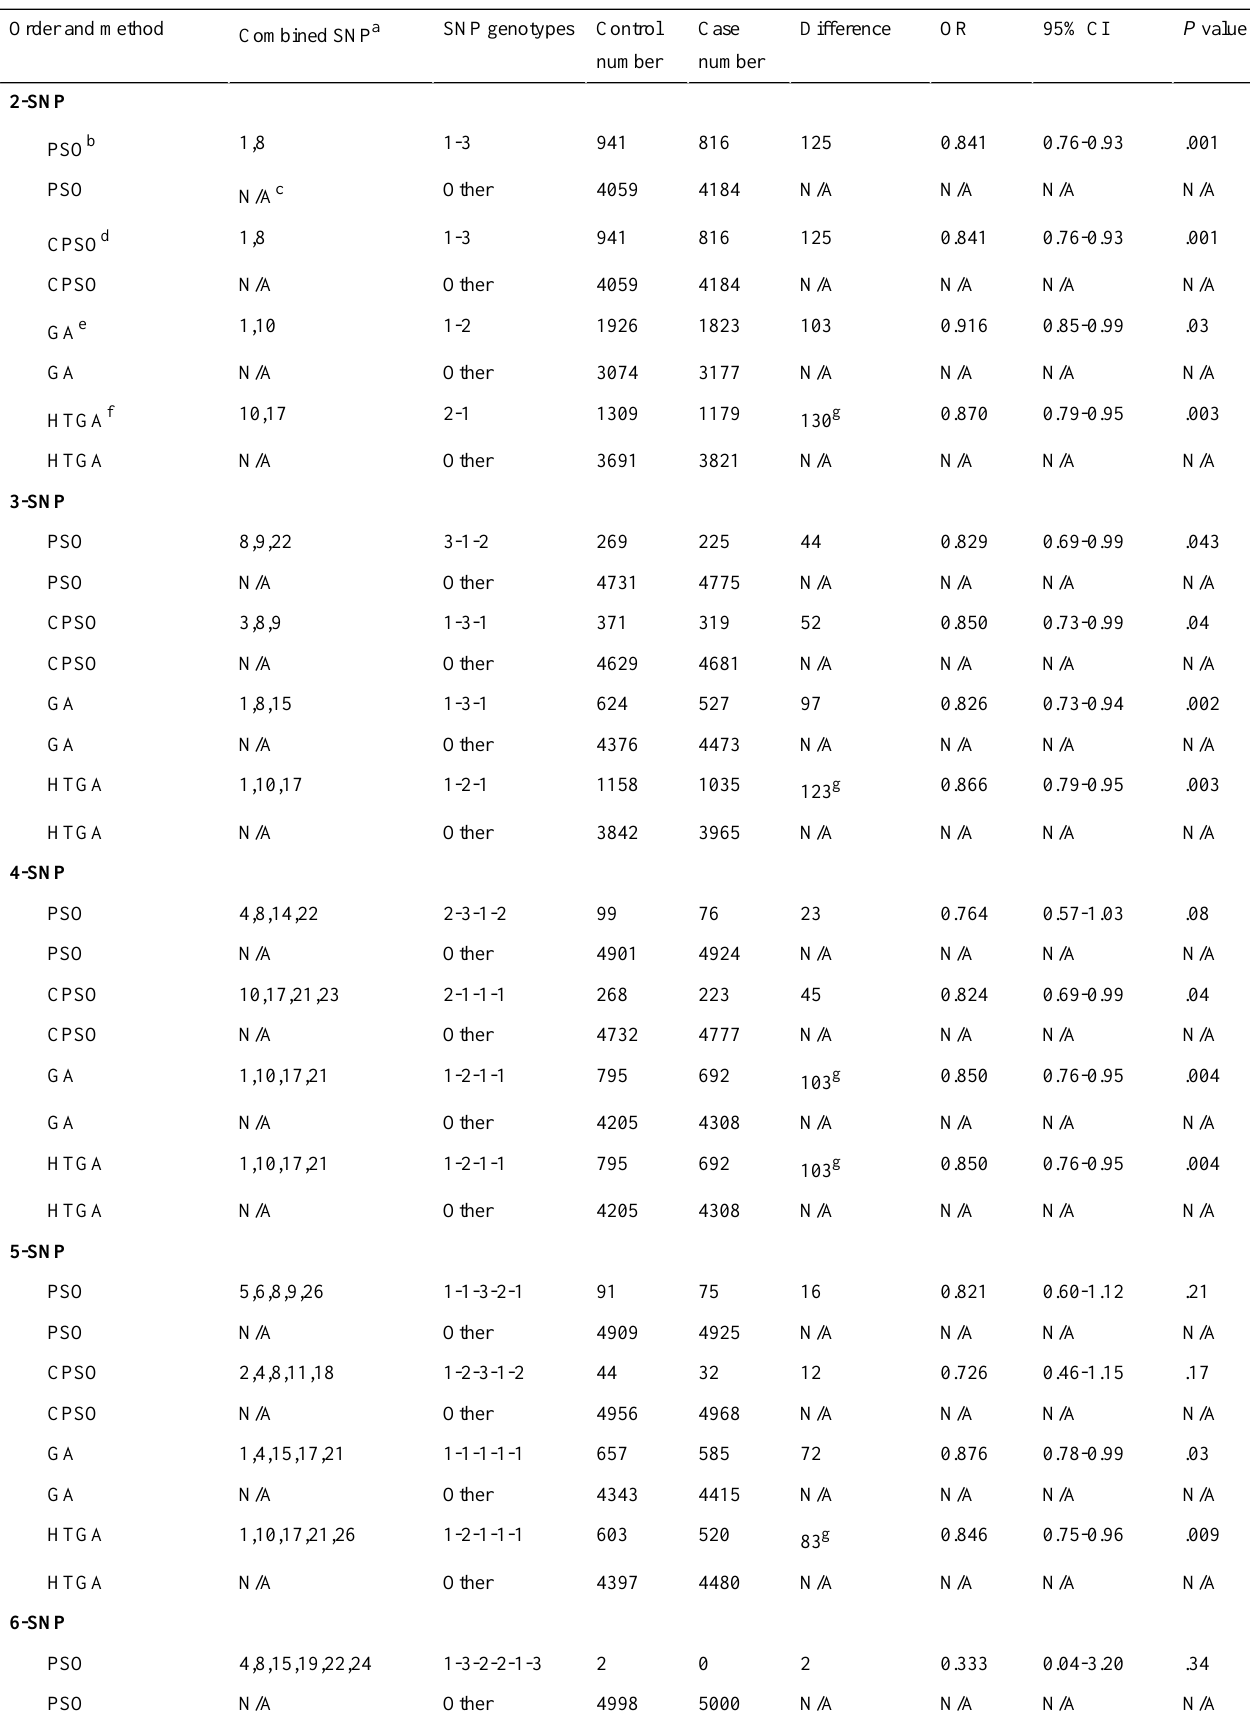
Table 3. Estimation of the best protection single-nucleotide polymorphism barcodes for the occurrence of breast cancer as determined by particle swarm optimization, chaotic particle swarm optimization, the genetic algorithm, and the hybrid Taguchi-genetic